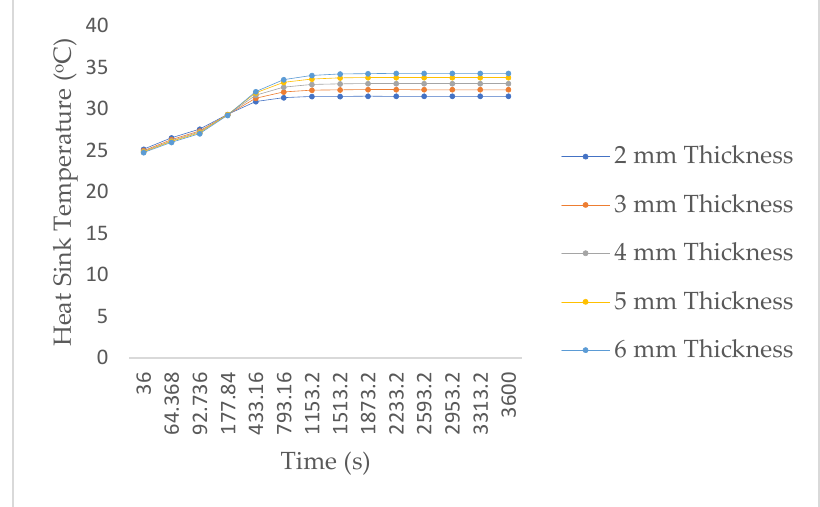
Figure 4. Temperature plot of heat sink at 4.55 W.